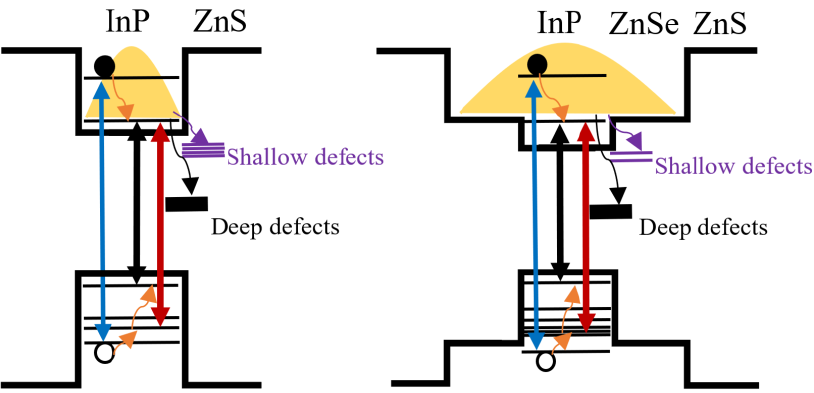
Figure 6. Schematic illustration of the relaxation process of photogenerated carriers in CS − QDs and CSS − QDs. For both, the blue two-way arrow indicates photoexcitation at 400 nm. The black and red two-way arrows represent the band-edge signals and short wavelength signals in the TA spectrum. The orange wavy arrow represents the in-band relaxation process of hot carriers, the purple wavy arrow represents the transition of electrons to shallow defects and the black wavy arrows indicate the transition of electrons to deep defects.